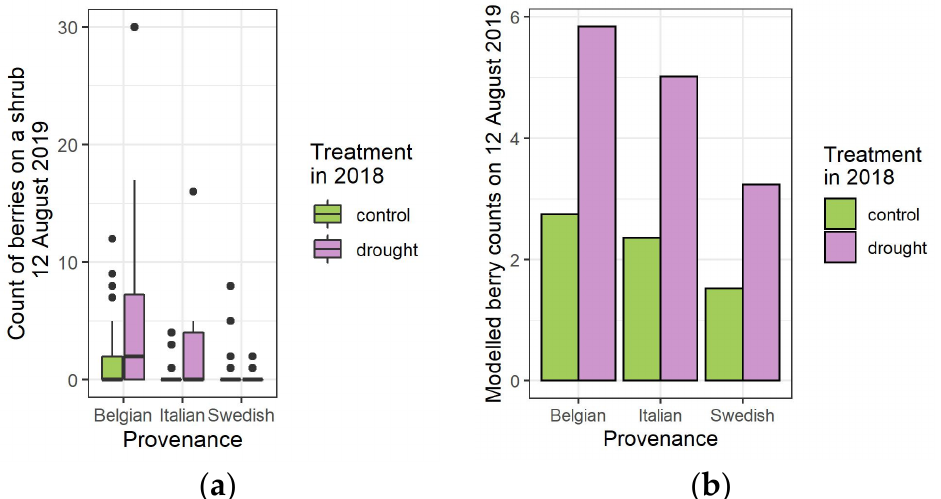
Figure 2. Actual ( a ) and modelled count of berries ( b ) on a shrub according to the treatment in 2018 and the provenance.